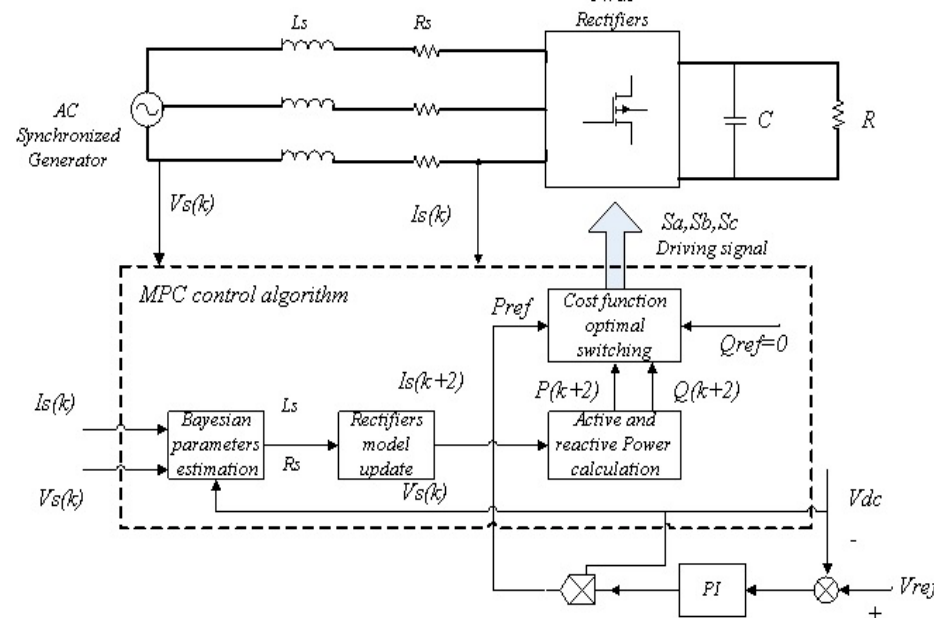
Figure 5. Block diagram of the proposed on-line parameter estimation algorithm with (model Predictive Direct Power Control) MPDPC.